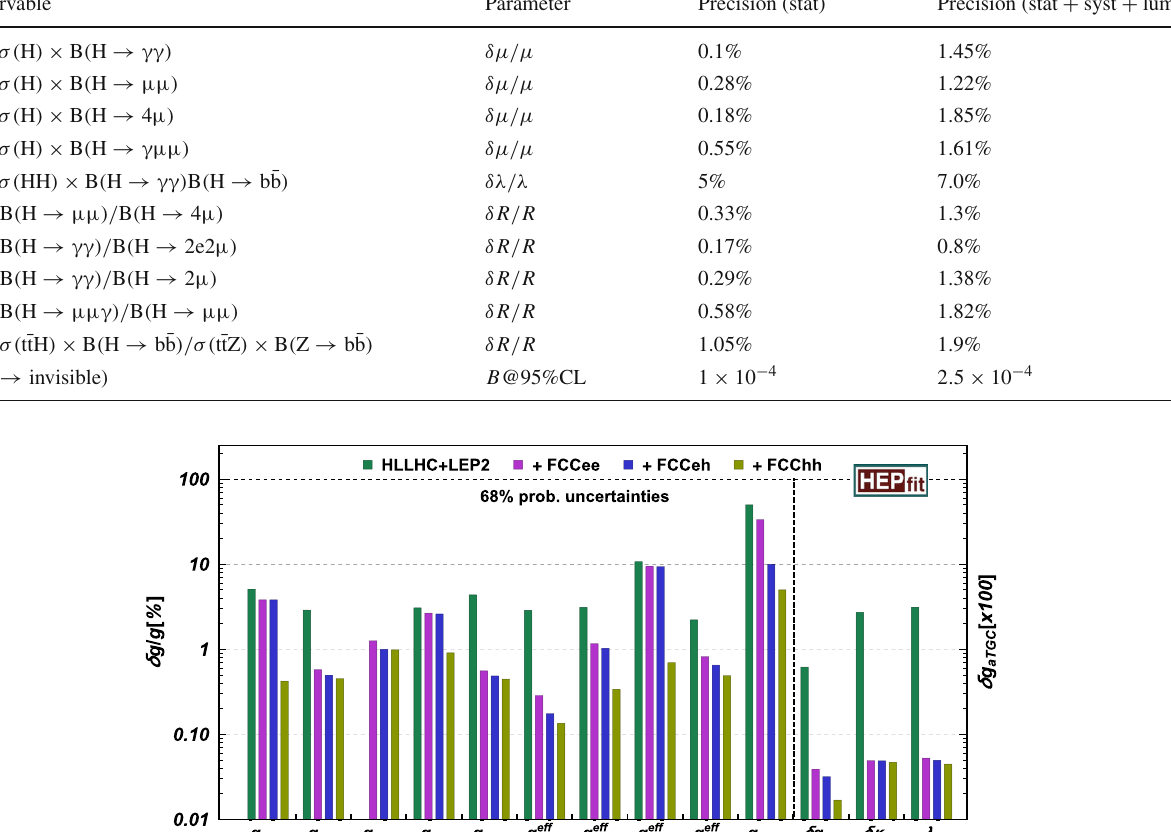
Table S.2 Target precision, at FCC-hh, for the parameters relative to the measurement of various Higgs decays, ratios thereof, and of the Higgs self-coupling. Notice that Lagrangian couplings have a precision Observable